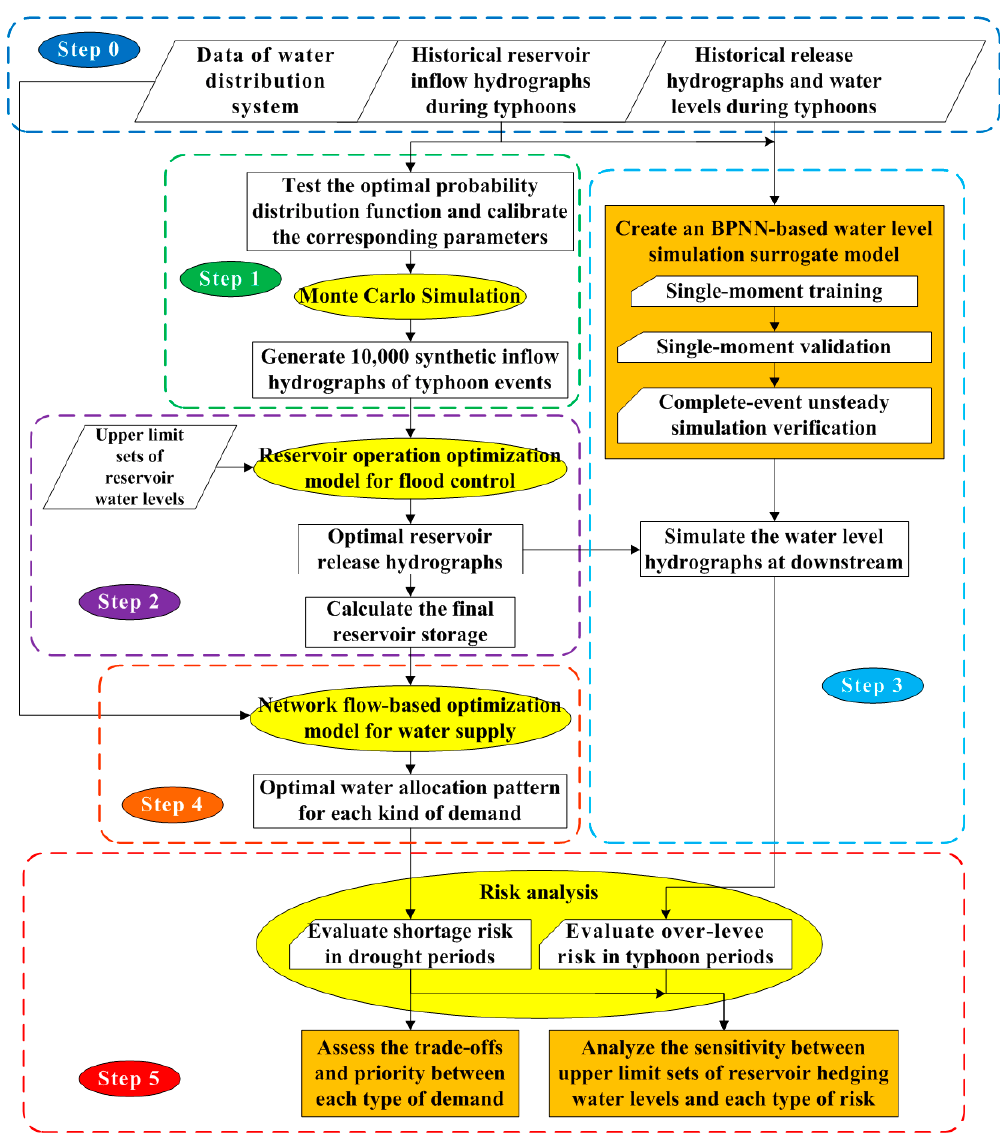
Figure 4. Flowchart of the proposed methodology.